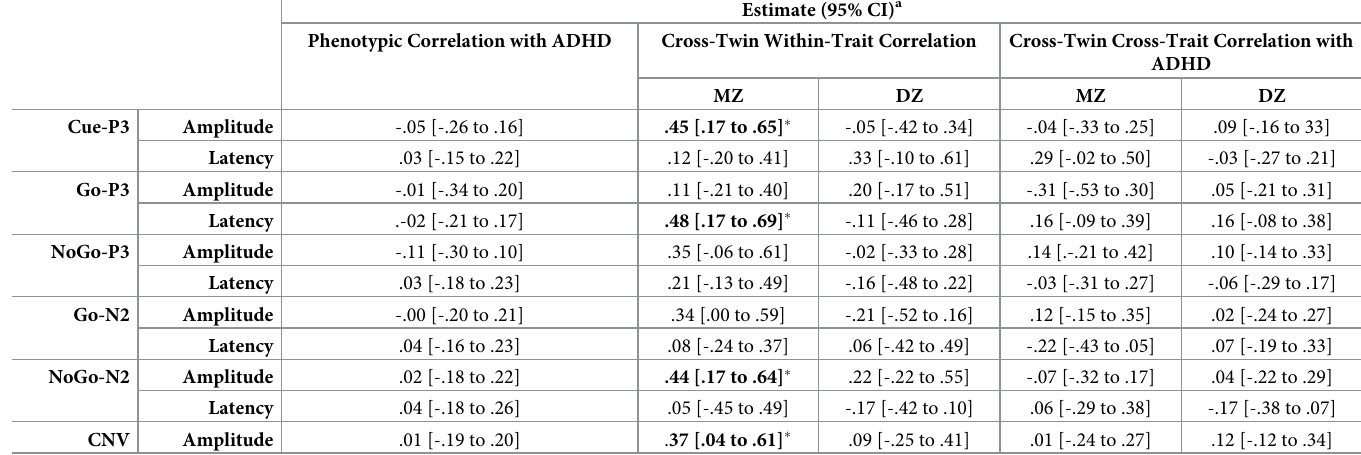
Table 3. MZ and DZ cross-twin within-trait correlations for all ERP measures and cross-twin cross-trait correlations between ADHD and all ERP measures from the flanked